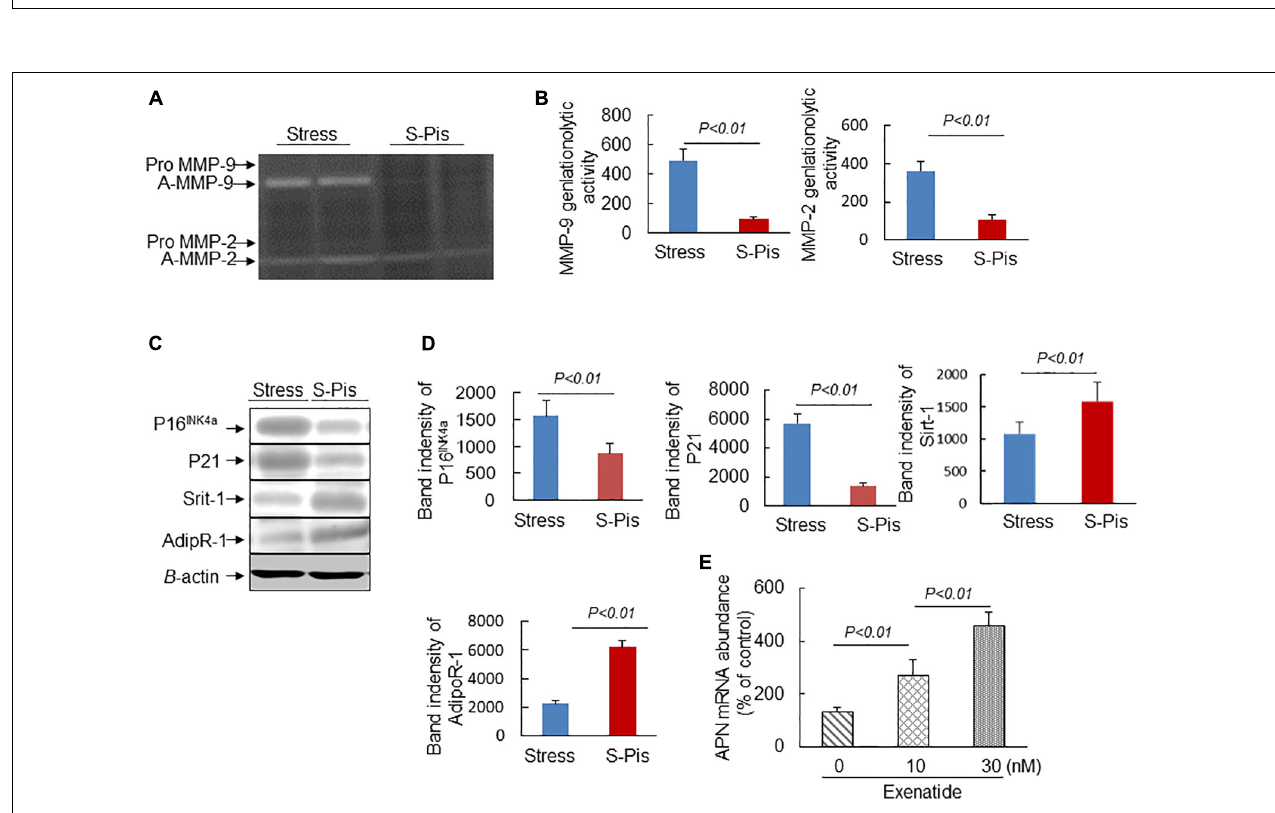
FIGURE 6 | Pitavastatin mitigated MMP-2/-9 expression/activity and targeted protein expressions in the aortic roots. (A,B) Representative gelatin zymography images and quantitative data for MMP-9 and MMP-2 activities. (C,D) Representative Western blot images and quantitative data show the protein expressions of P16 INK 4 a , P21, Sirt-1, and Adip R-1. (E) Exenatide elevated APN gene expression in the stressed mouse inguinal adipose tissue-derived immature adipocytes. Values are presented as means ± SEM ( n = 3–6). p < 0.05, p < 0.01 vs. Stress group by Student’s t -test and one-way ANOVA followed by Tukey post hoc tests.